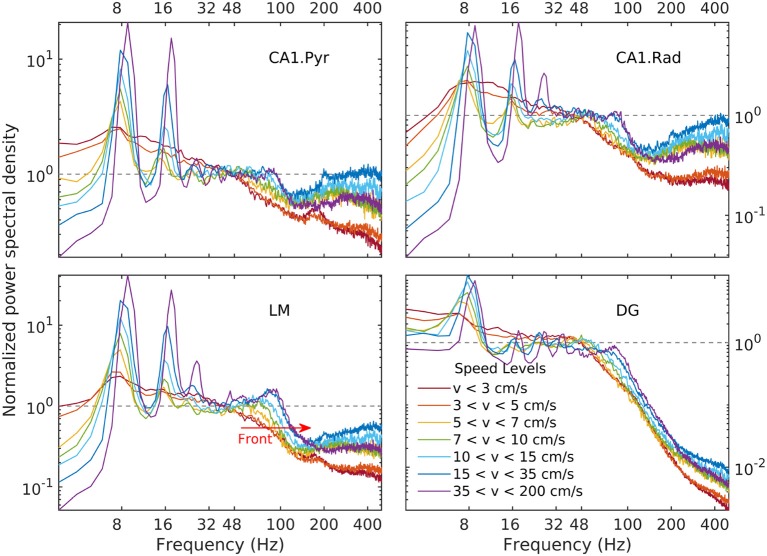
Normalized LFP spectrum estimated for CA1.pyr, CA1.rad, LM, and DG layers as a function of speed. Frequency spectra are normalized by dividing them by the corresponding power law, i.e., s(f)=S(f)S(f0)(ff0)αlayerv, where S is the power spectrum, s is the normalized spectrum, and f0 = 48 Hz. The dependency of the LM gamma band on speed has the appearance of a spectral “front” moving to the right (red arrow), as it steepens and develops a peak. A similar behavior may be seen in all layers. Note that because the limits of vertical axes for the LM and DG layers (lower panels) are different, the spectral front appears to be weaker in the DG layer than in the LM layer. In fact, at the gamma peak (around 80 Hz, lower panels in Figure 3) the spectral densities grow by remarkably similar factors (≈ 3).